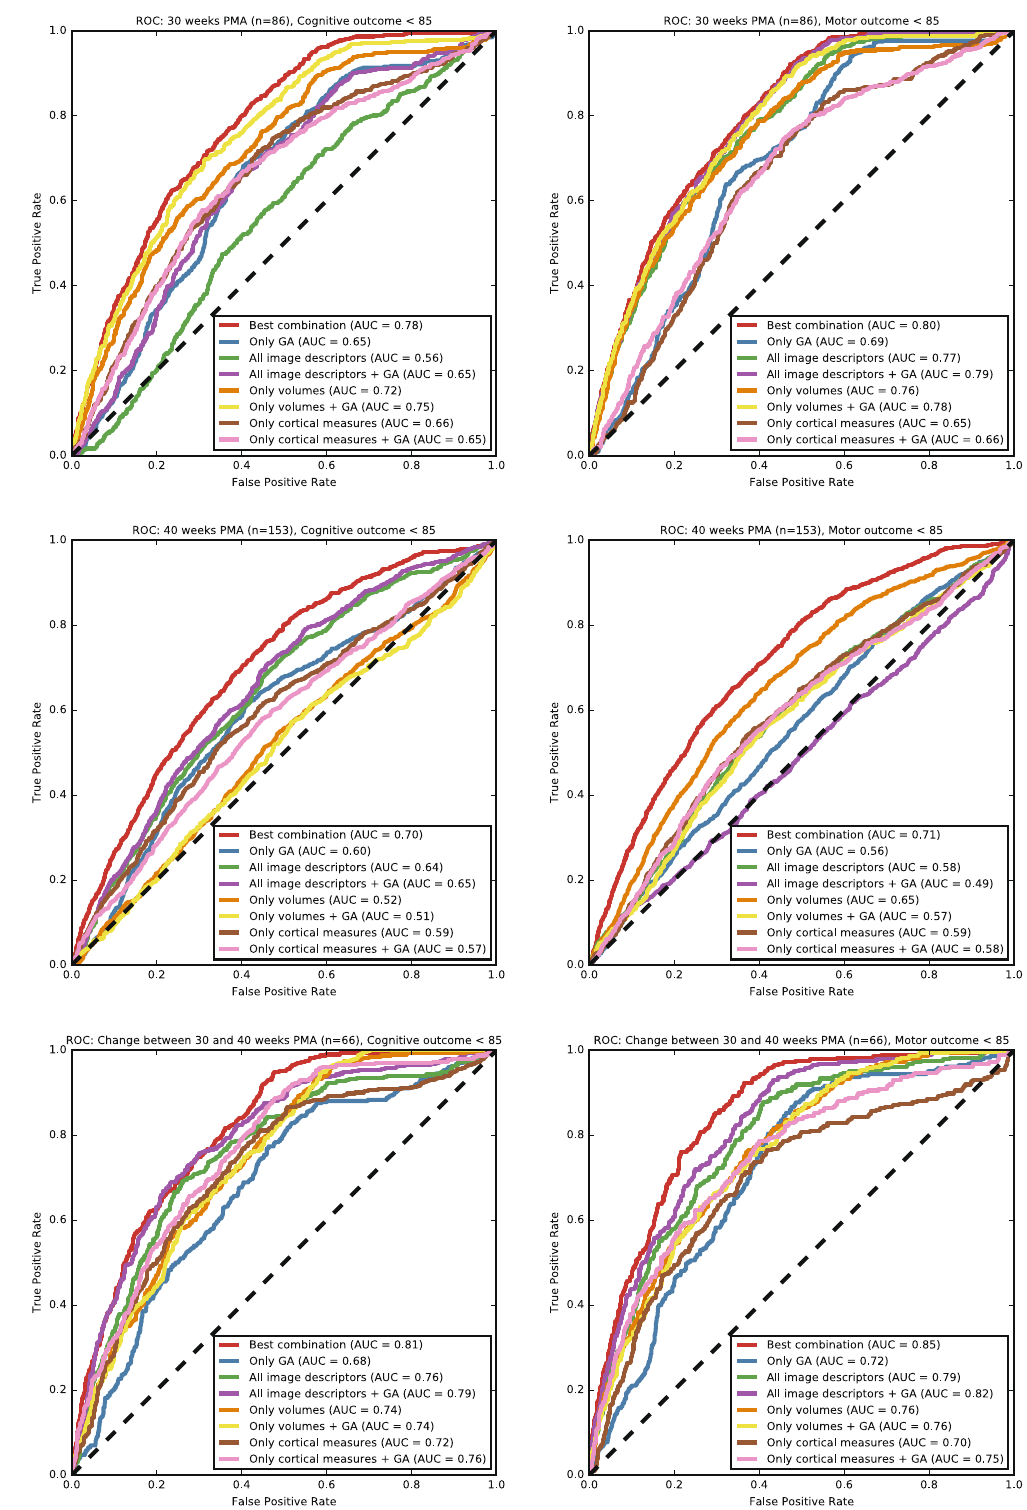
Figure 3. ROC curves for the prediction of patients with a cognitive (left) and motor (right) outcome below 85 as assessed by the BSID-III based on the images acquired at 30 weeks PMA (top), the images acquired at 40 weeks PMA (middle), and the change between the descriptors computed at 30 and 40 weeks PMA (bottom). The results are shown using: the best performing combinations from Tables 2, 3 and 4; only GA; all image descriptors; all image descriptors and GA; relative tissue volumes and intracranial volume; relative tissue volumes, intracranial volume, and GA; measures of cortical morphology; and measures of cortical morphology and